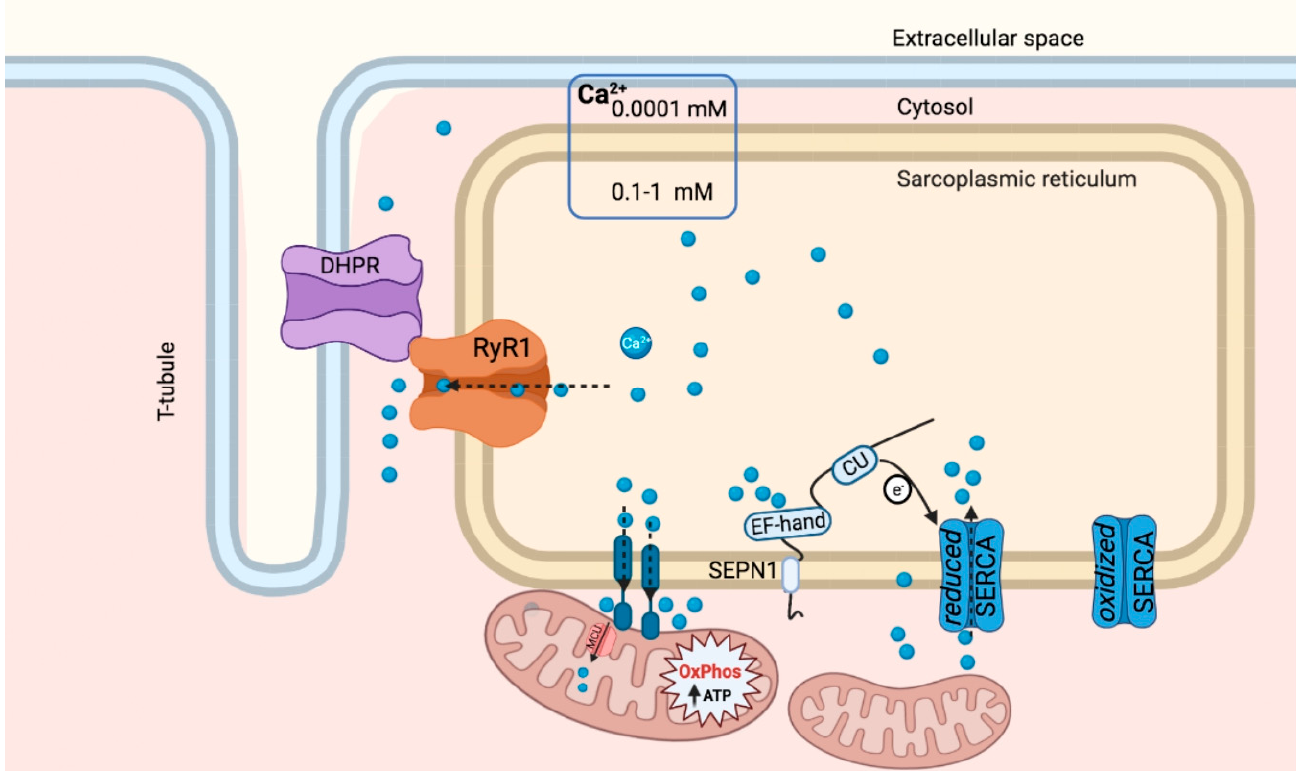
Figure 2. SEPN1 ‐ mediated calcium handling and muscle phenotype of SEPN1 ‐ RM. The functional relationship between SEPN1 and RYR1 in the SR is illustrated. Both proteins tune the ER calcium handling: RYR1 is a Ca 2+ (blue spheres) release channel of the SR, which is activated by the dihydropyridine receptor (DHPR) on the T tubule, and SEPN1 senses ER calcium (blue spheres) levels through an EF ‐ hand domain. Then, SEPN1 activates, through a redox reaction involving the thioredoxin ‐ like domain CU (the arrow indicates an electron flow from the nucleophilic U), the calcium pump SERCA, which leads to calcium uptake into the ER. Ca 2+ direction is indicated by dashed arrows. The range of intraluminal and cytosolic Ca 2+ is indicated. SEPN1 is enriched at MAMs, a region of the ER in close contact with mitochondria through proteinaceous tethers, which is important for calcium mobilization from the ER to mitochondria. Calcium is released from ER via IP3R or RYR (not depicted) and is internalized in mitochondria through a voltage ‐ dependent anion channel (VDAC) (not depicted), which is on the outer mitochondrial membrane, and through the mitochondria calcium uniporter (MCU), which is on the inner mitochondrial membrane [18]. Consequently, SEPN1 loss also impairs mitochondrial calcium and ATP levels by hampering the OXPHOS.